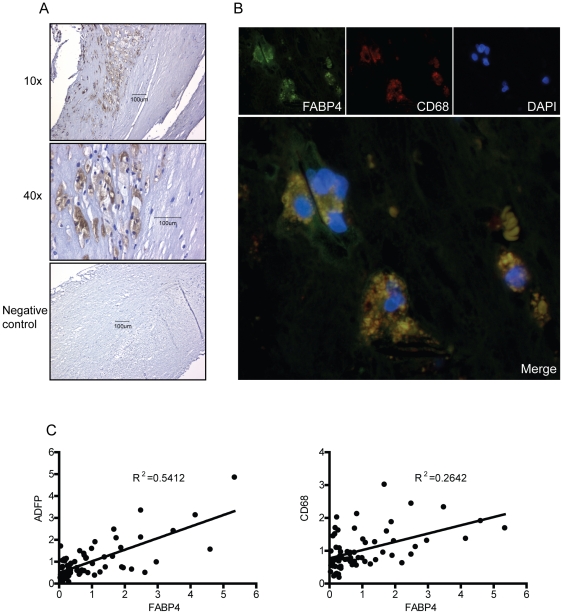
FABP4 is co-localized to macrophages within carotid atherosclerotic plaques.Panel A shows immunostaining of FABP4 in symptomatic carotid atherosclerotic plaques (n = 2) primarily located to macrophage-rich areas. Representative images obtained with 10x and 40x objective. Panel B shows double immunofluorescent staining of FABP4 (green fluorescence), CD68 (macrophages, red fluorescence) and nucleus (DAPI, blue fluorescence) from symptomatic carotid atherosclerotic plaques (n = 2). The lower panel is a merge of the three pictures above. Panel C shows the correlations of mRNA levels in atherosclerotic plaques between FABP4, ADFP and CD68, respectively.